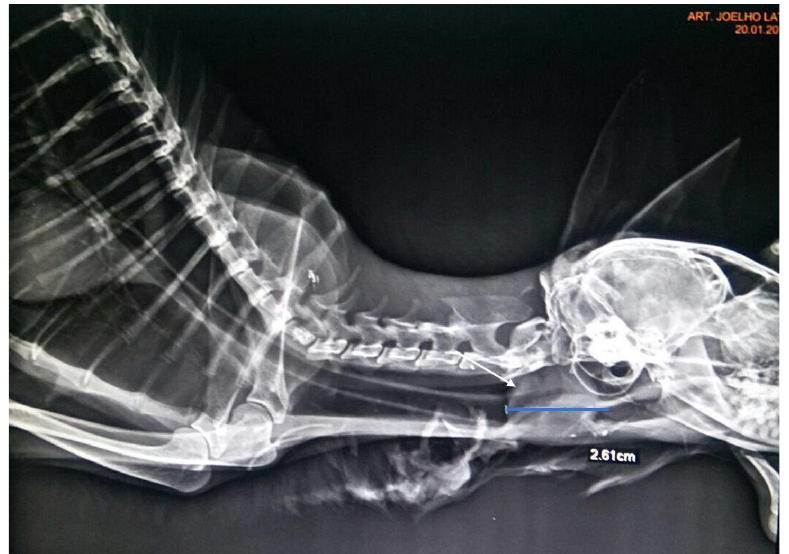
Figura 3. Exame radiográfico da região cervical do paciente relatado, na posição latero-lateral, evidenciando estrutura oval (seta) de média radiopacidade, medindo cerca de 2,6 cm em seu maior eixo, sobrepondo topografia da laringe.